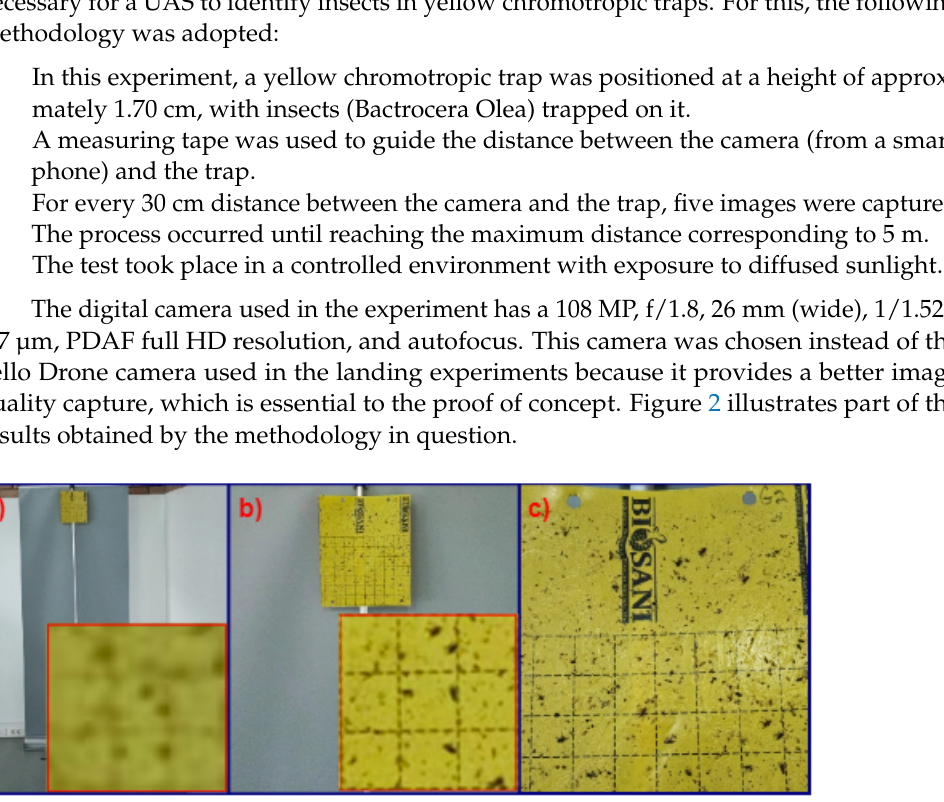
Figure 2. Image capture of the trap at three different distances. ( a ) 3.5 m with 5 × digital zoom in detail; ( b ) 1.5 m with 2 × digital zoom in detail; ( c ) 0.30 m with no digital